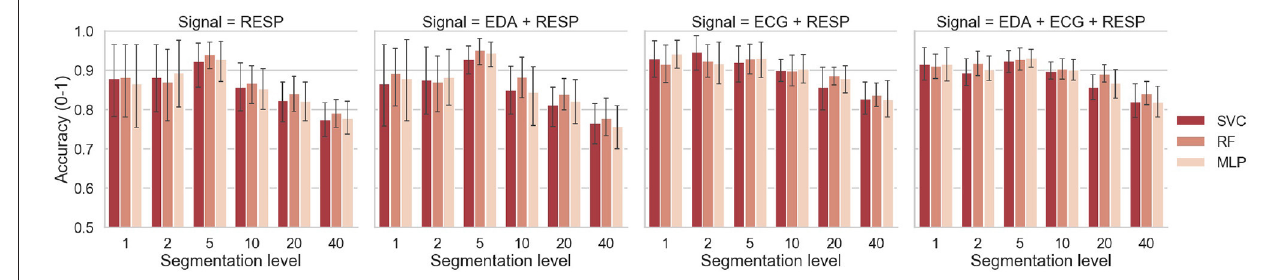
FIGURE 6 | Classification accuracy as a function of the segmentation level and classifier. TABLE 6 | Best score for each segmentation level, with corresponding signals and classifier. Segmentation